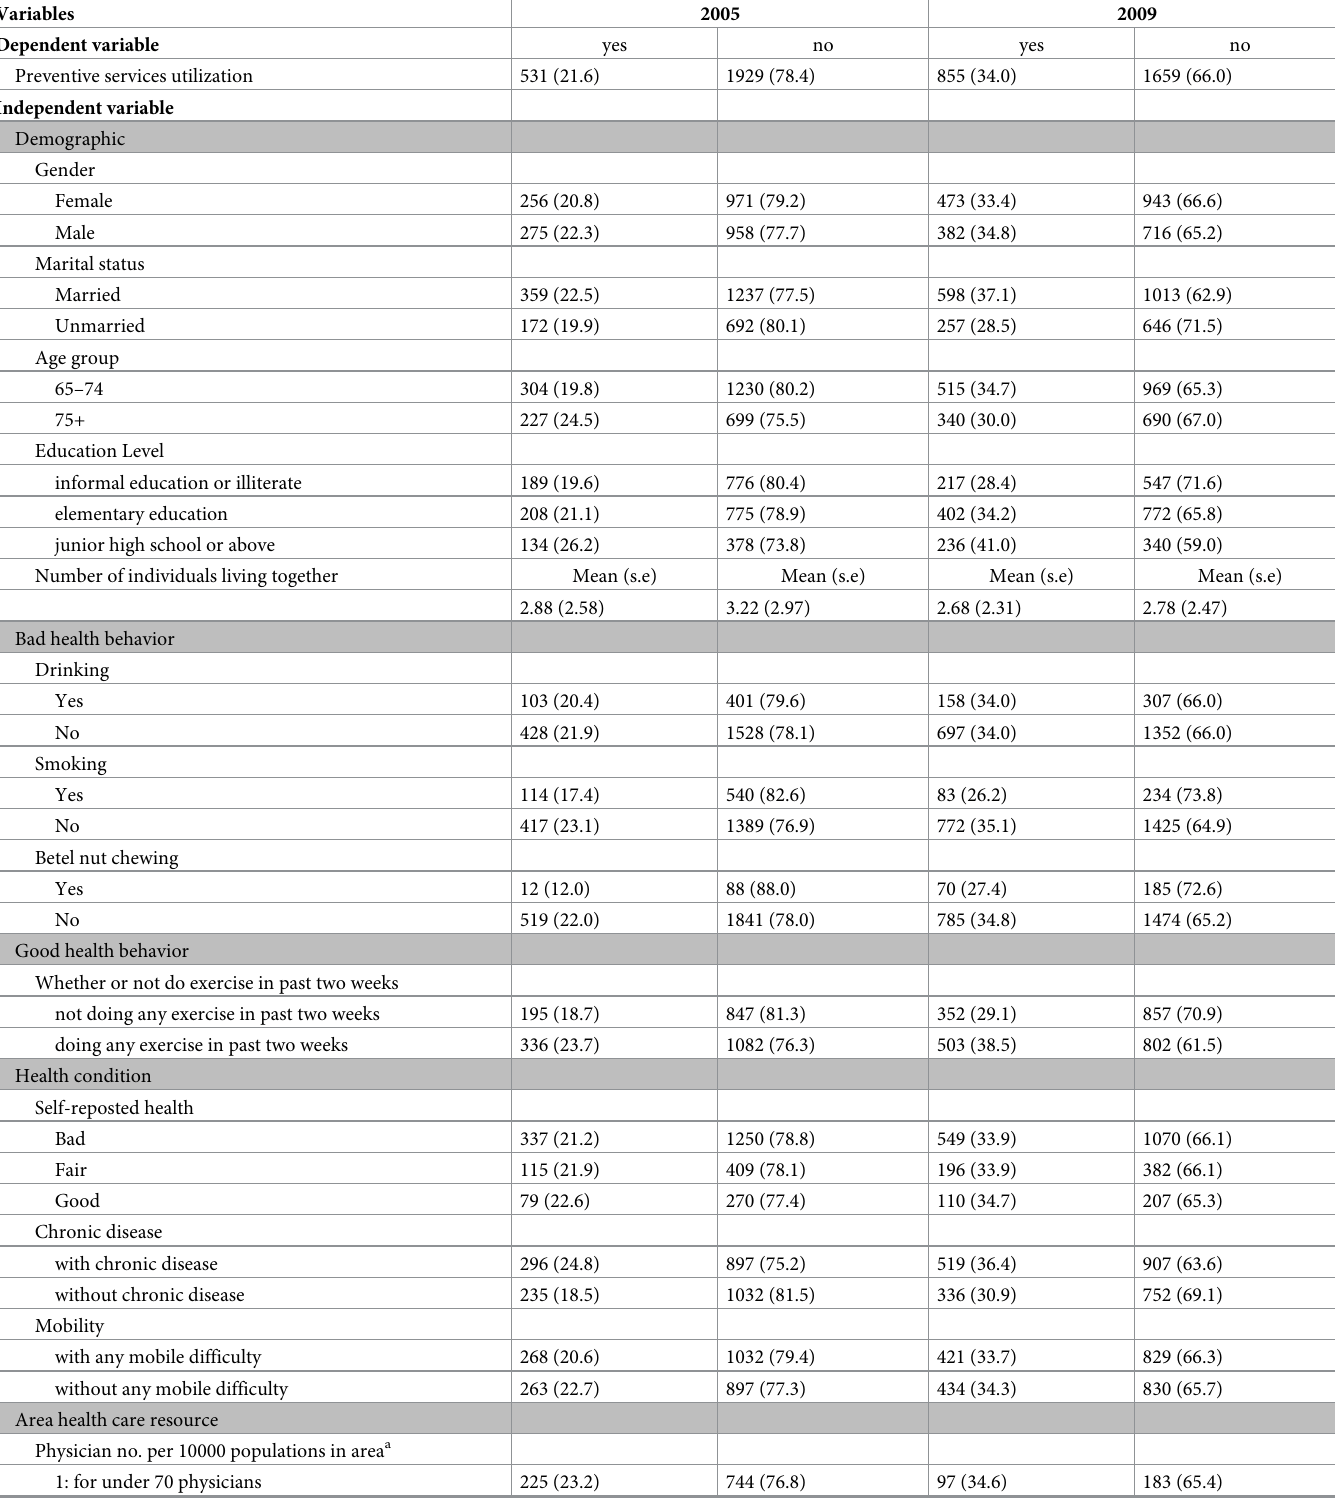
Table 1. Study sample characteristics by health check-ups (health examination) use and year, n